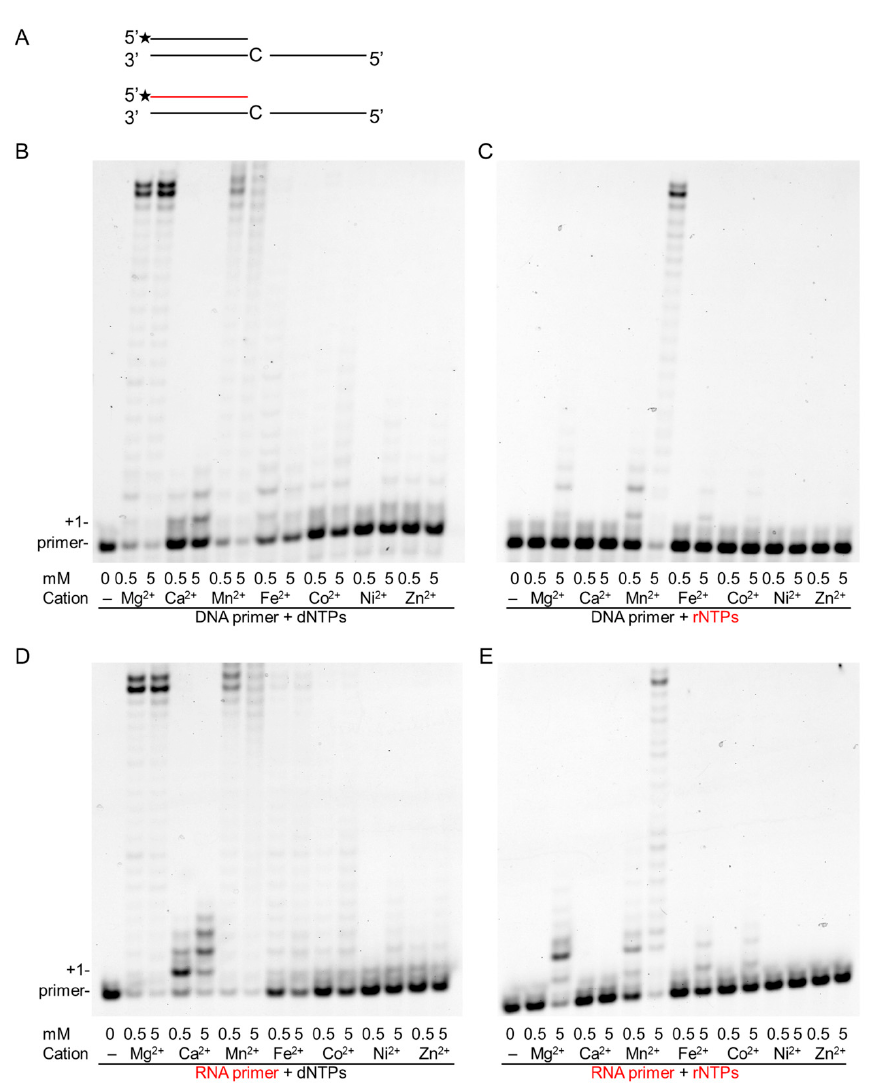
Figure 1. Effect of various divalent cations on the primer extension activities of Pol η . In-vitro primer extension reactions were performed with 40-nM Pol η for 5 min in the presence of two different concentrations of the indicated divalent cations. ( A ) The structures of the primer/template used in the experiments are shown. The RNA primer is depicted in red. Asterisks (*) indicate fluorescently labeled primer ends. Reactions were carried out in the presence of ( B ) DNA primer and deoxy-ribonucleoside-triphosphates (dNTPs), ( C ) DNA primer with ribonucleoside-triphosphates (rNTPs), ( D ) RNA primer with dNTPs, and ( E ) RNA primer and rNTPs. Reactions in ( B – E ) contained 30 nM of the hybridized primer/template, and close to physiological concentrations of nucleotides, either 50 µM of dNTPs or 1 mM of rNTPs. The positions of the primer and its extension by one nucleotide are indicated. RNA primers and rNTPs are highlighted in red.